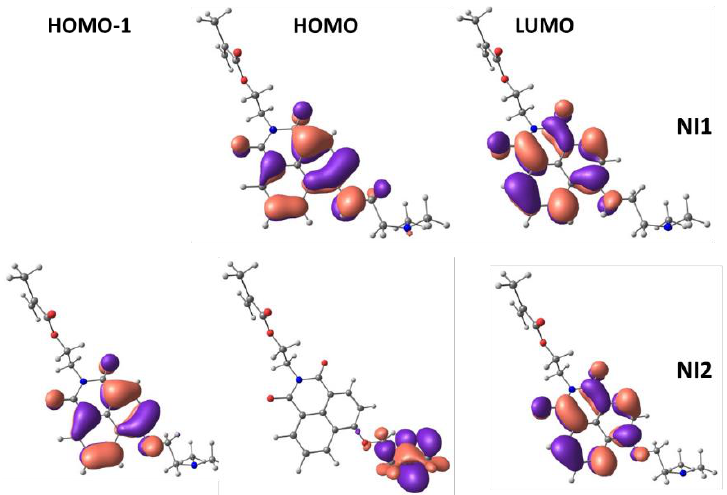
Figure 8. Graphical representation of the frontier orbitals (isodensity plot, isovalue = 0.02 a.u.). It should be noted that the implicit solvent model used treats solvent as a continuous medium and does not differentiate protic (methanol and water) from aprotic (DMF) polar solvents ( ε >